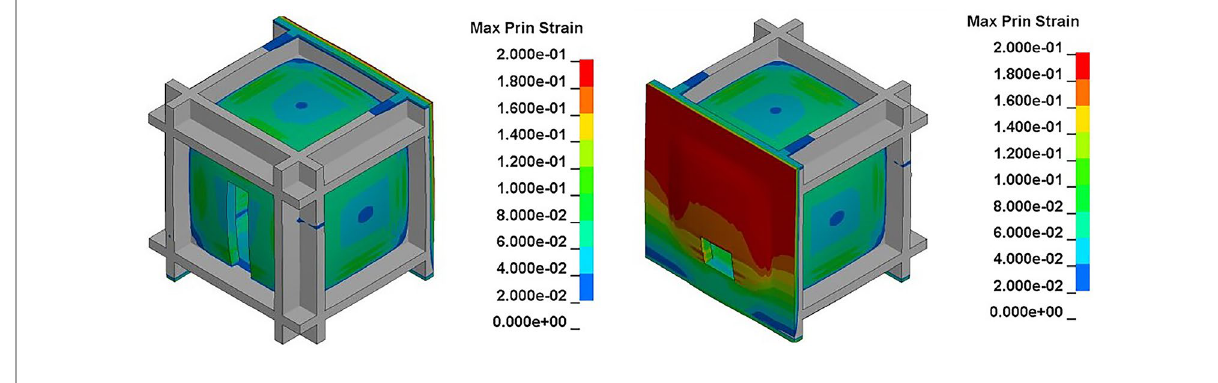
Fig. 23 Deformation